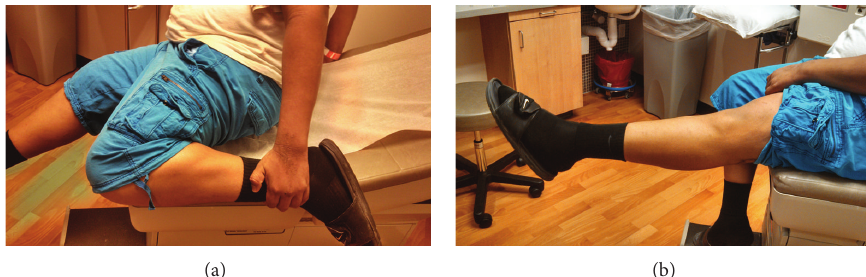
Figure 6: Five-month postoperative photos demonstrating full flexion (a) and extension (b).